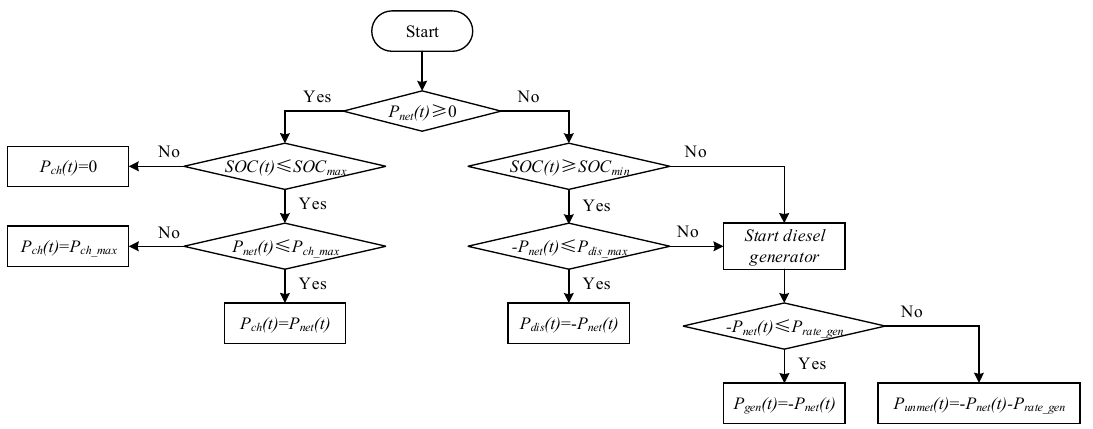
Figure 3. The flowchart of control strategy.